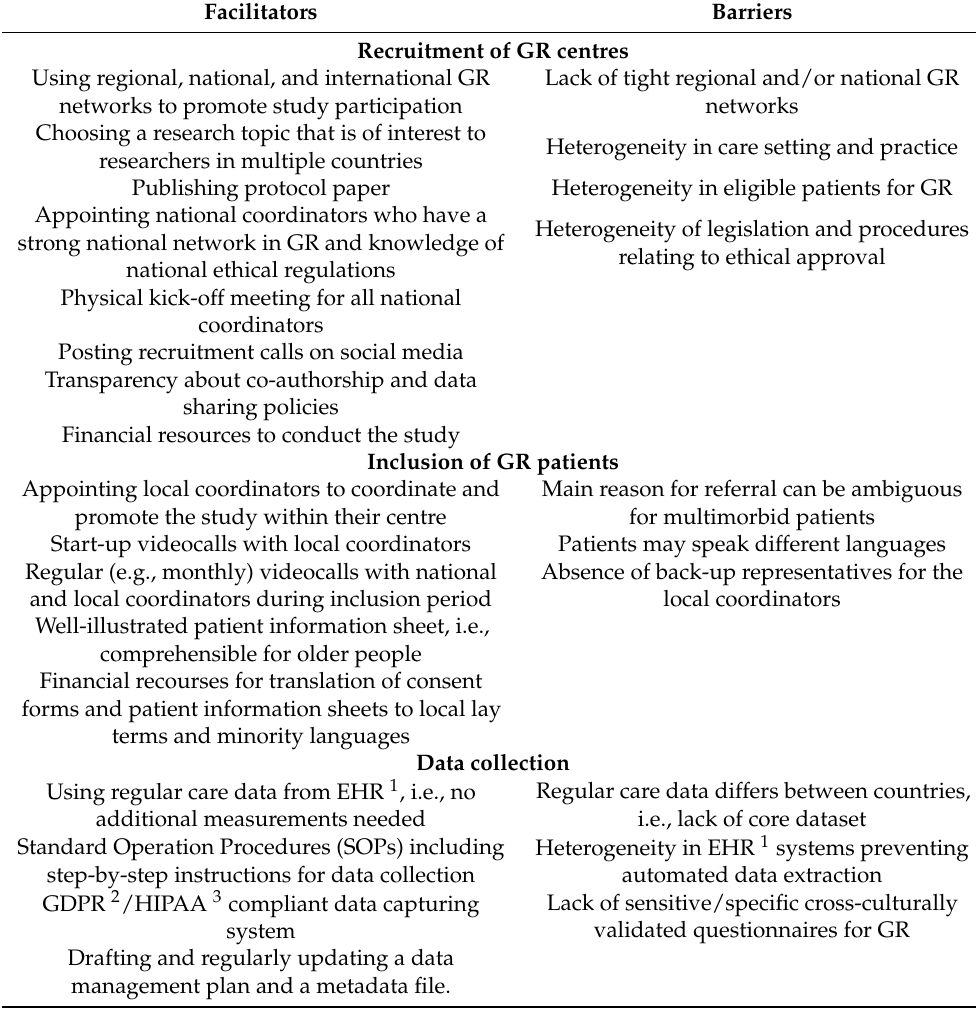
Table 1. Facilitators and barriers for conducting cross-national GR research. Facilitators Barriers Recruitment of GR